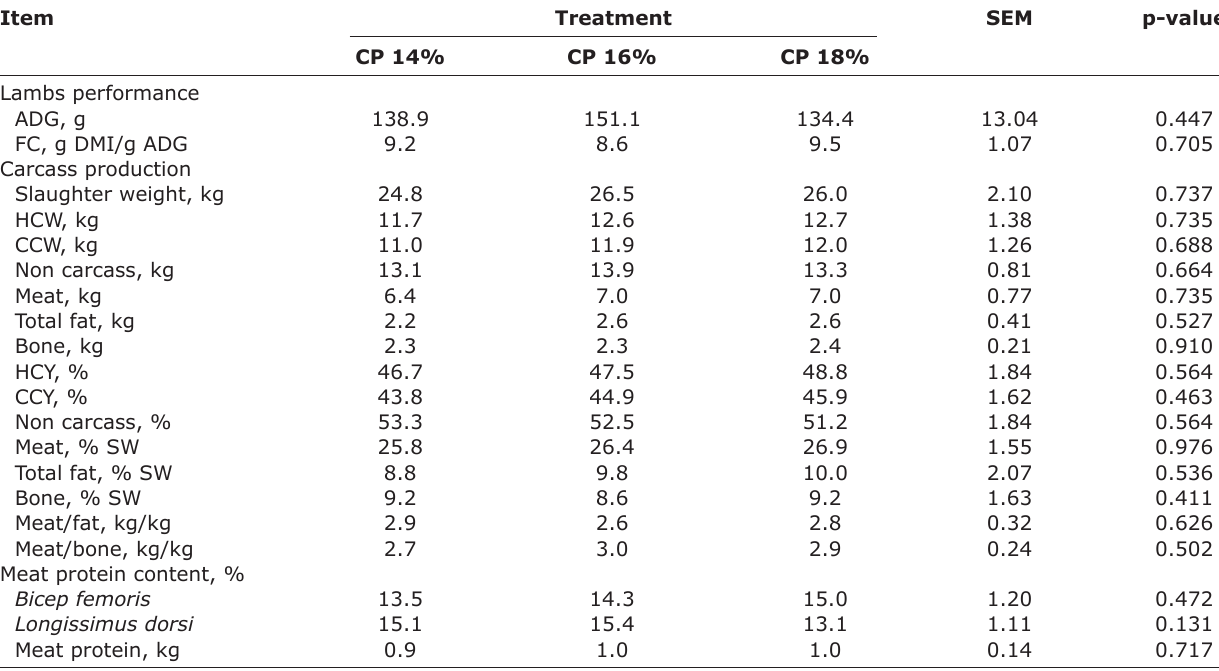
Table-2: ADG and carcass